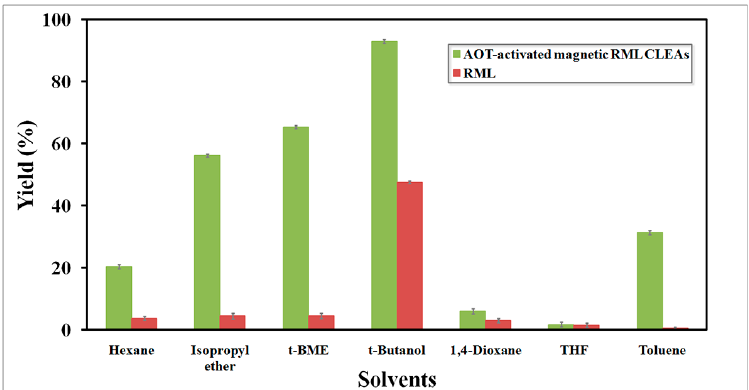
Figure 10. Effect of different solvents on AOT-activated magnetic RML CLEAs catalyzed biodiesel production from jatropha oil.